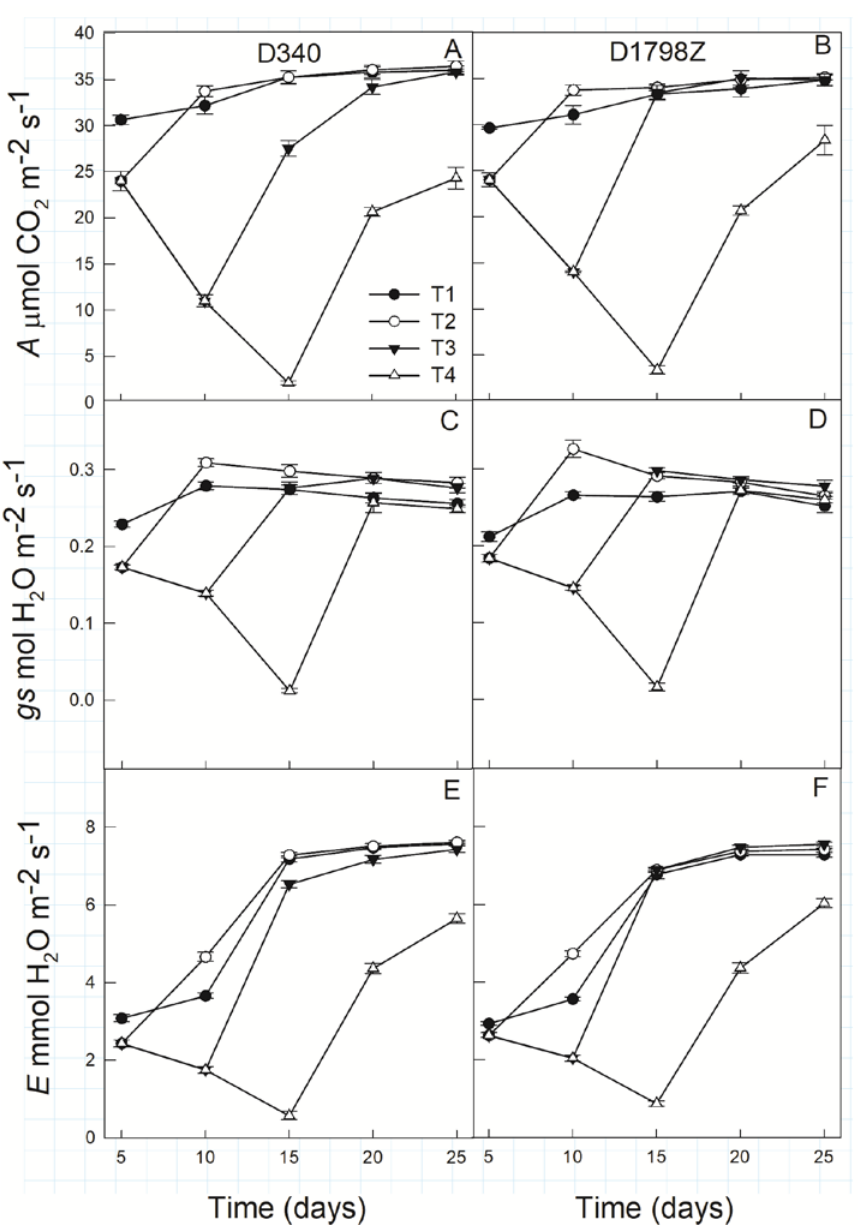
Figure 3. Effect of different drought durations and re-watering on A , Photosynthetic rate ( A – B ), g s , Figure 3. E ff ect of di ff erent drought durations and re-watering on A , Photosynthetic rate ( A , B ), g s , Stomatal conductance ( C – B ) and E , Transpiration rate ( E – F ) of two maize lines. Each parameter is the Stomatal conductance ( C , D ) and E , Transpiration rate ( E , F ) of two maize lines. Each parameter is the average of three replicates. average of three